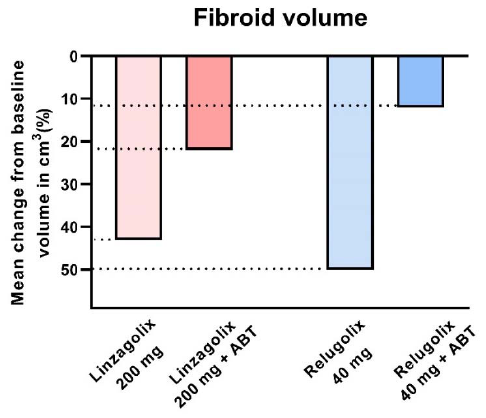
Figure 5. Percentage of women meeting the primary endpoint (those with menstrual blood loss of less than 80 mL and at least 50% down from baseline) in patients treated by a GnRH antagonist combined with add-back therapy (ABT) in the first and second clinical trial respectively (300 mg elagolix twice daily + ABT (Elaris 1 and 2); 200 mg linzagolix once daily + ABT (Primrose 1 and 2); 40 mg relugolix once daily + ABT (Liberty 1 and 2)).